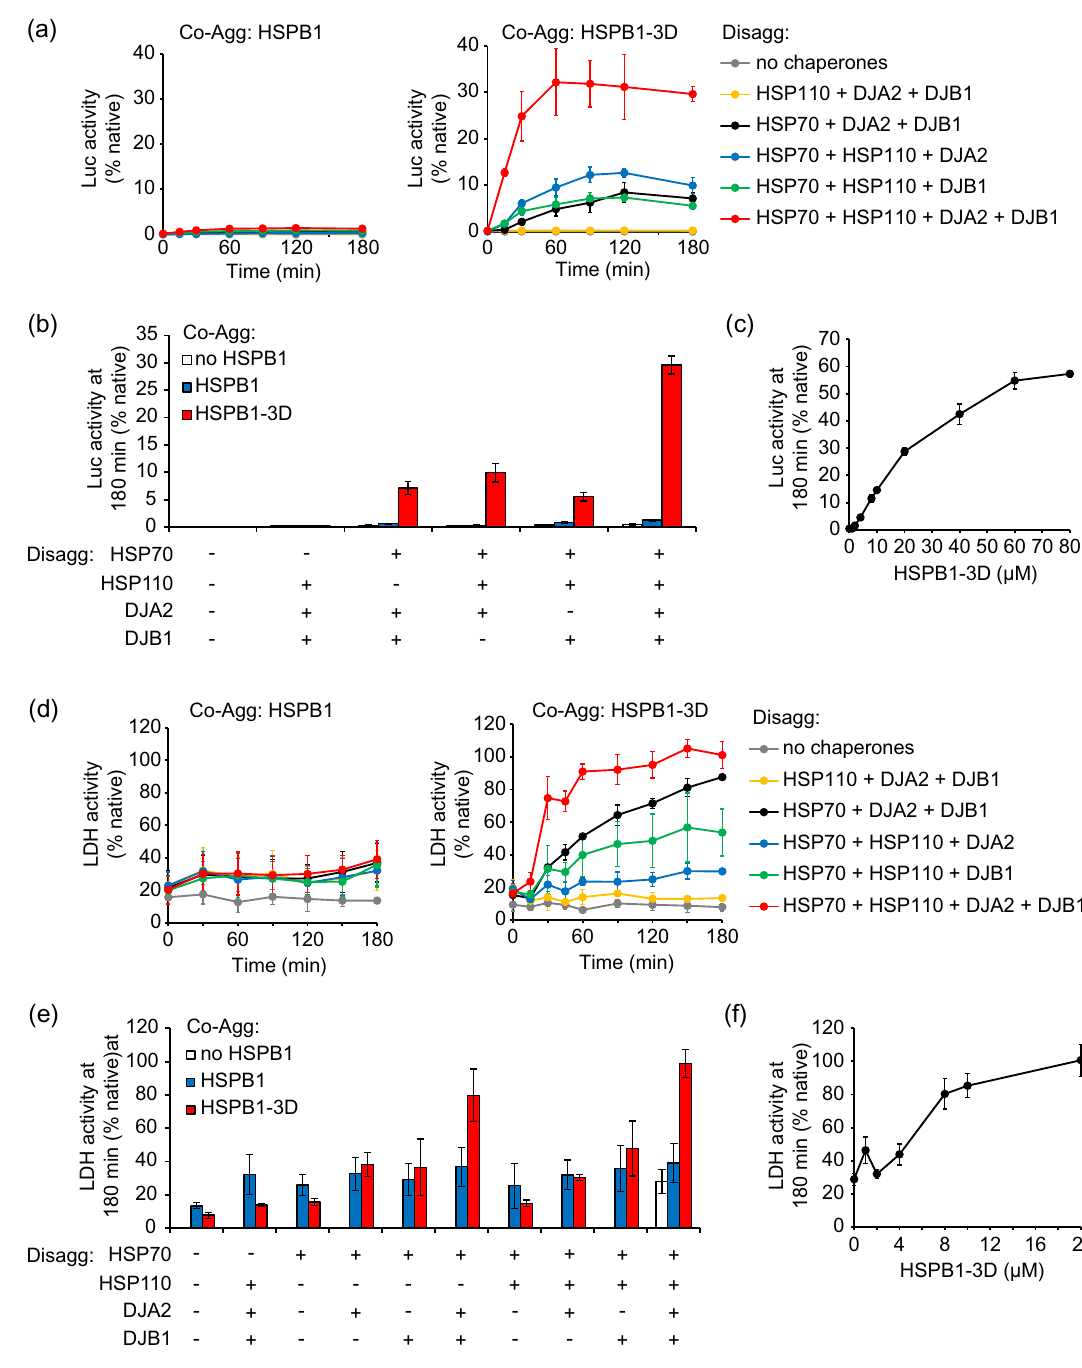
Figure 5. HSPB1-3D-dependent disaggregation results in refolding. Disaggregation reactions with heat shocked ( a – c ) luciferase or ( d - f ) LDH aggregates formed in the absence or presence of HSPB1 or HSPB1-3D were performed as described above. Substrate enzymatic activities were monitored over time in reactions containing the indicated chaperone combinations. Kinetics of ( a ) luciferase and ( d ) LDH reactivation from aggregates with HSPB1 or HSPB1-3D are reported relative to native substrate activity. ( b ) Luciferase and ( e ) LDH enzymatic activities as in a or d, after 3 h of disaggregation reaction with different combinations of chaperones. ( c ) Luciferase or ( f ) LDH enzymatic activities after 3 h disaggregation reaction. Error bars show standard deviations, n ≥